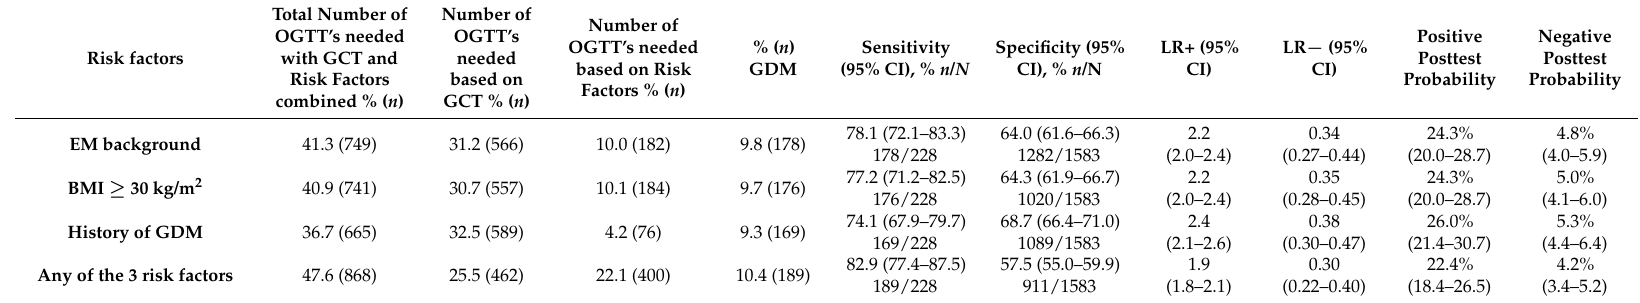
Table 4. Sensitivity and specificity of the GCT using a threshold of 7.2 mmol/L combined with clinical risk